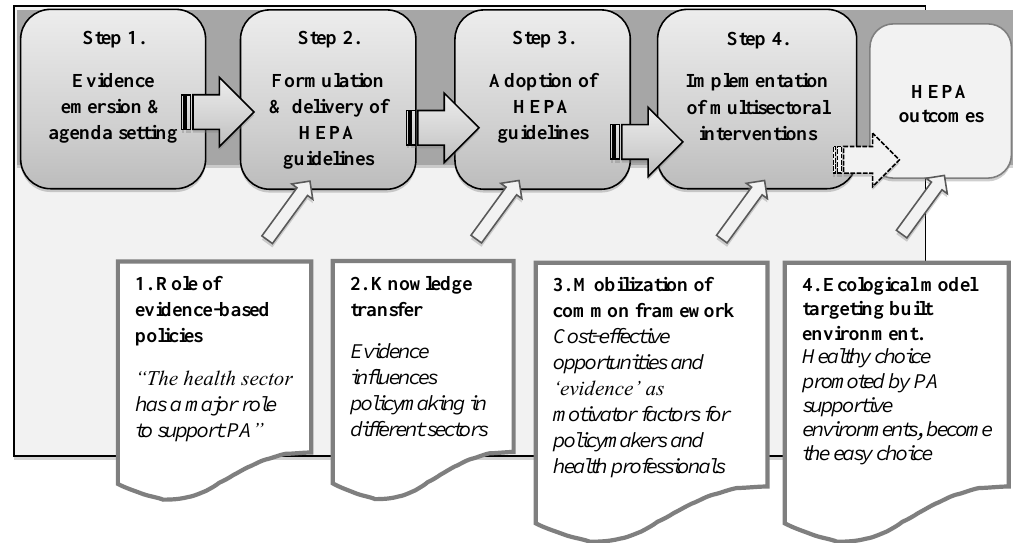
Figure 1. Main steps and assumptions of the initial basic programme theory: the chain from health-enhancing physical activity (HEPA) guidelines delivery to practices.